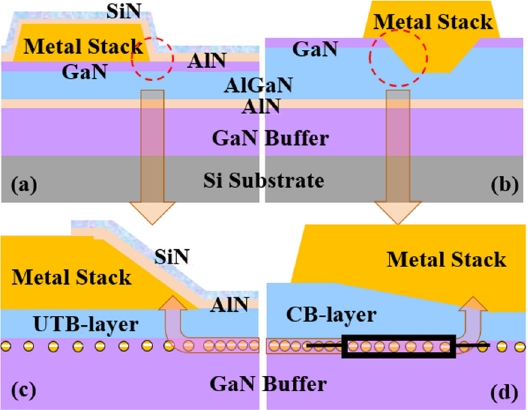
Figure 5. Schematic contact mechanisms of ohmic contacts to ( a ) UTB − AlGaN/GaN het- erostructure and ( b ) CB − AlGaN/GaN heterostructure. Different distribution of 2DEG between ( c ) UTB − AlGaN/GaN heterostructure and ( d ) CB − AlGaN/GaN heterostructure.